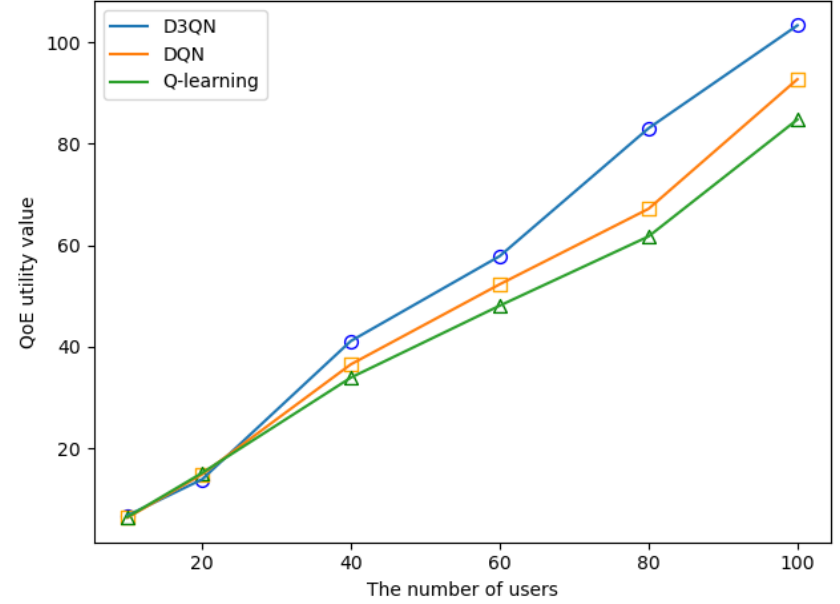
Figure 3. The comparison of QoE performance among different